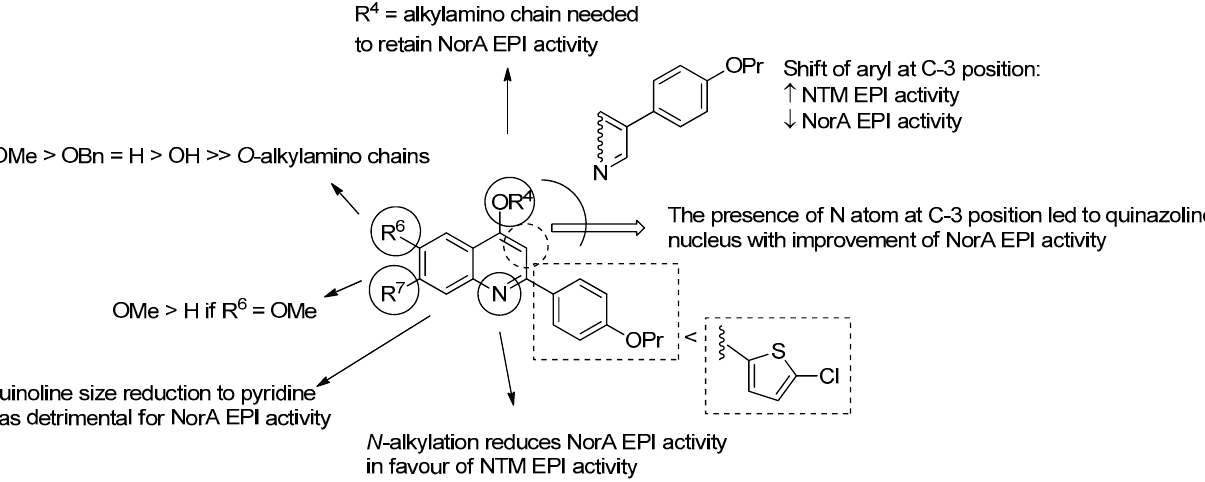
Figure 10. SAR of quinoline derivatives as NorA EPIs.